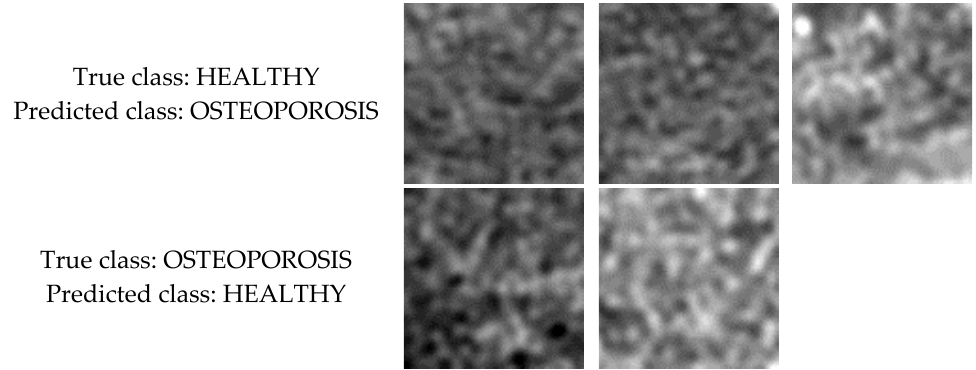
( f ) Figure 13. Confusion matrices: ( a ) VGG16; ( b ) VGG19; ( c ) MobileNetV2; ( d ) Xception; ( e ) ResNet50; and ( f ) InceptionResNetV2. As shown in Figure 3, the tissue image texture of healthy patients is smooth and ho- mogeneous. In the case of sick patients, the texture of the tissue image is characterised by porosity and a significant number of dark spots corresponding to osteoporotic lesions. These texture properties are reflected in the feature maps built by the subsequent convo- lutional network layers. For the cases shown in Figure 14, the images of healthy patients